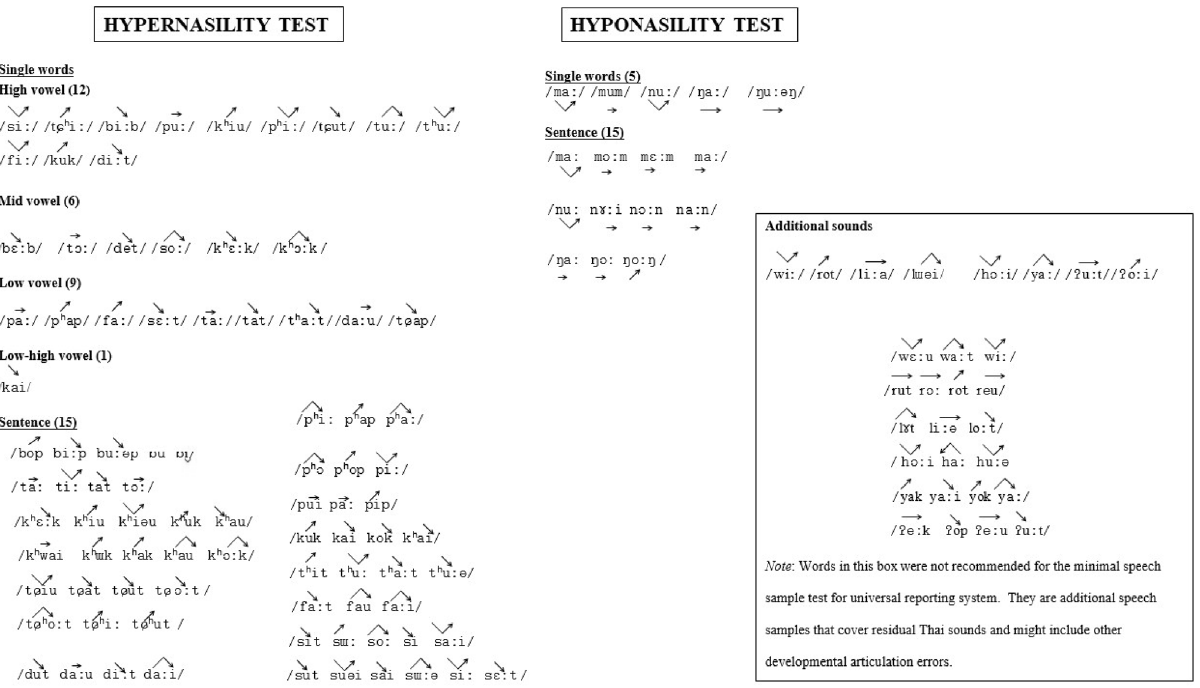
Figure 1. Set of words and sentences used for the acoustic perception